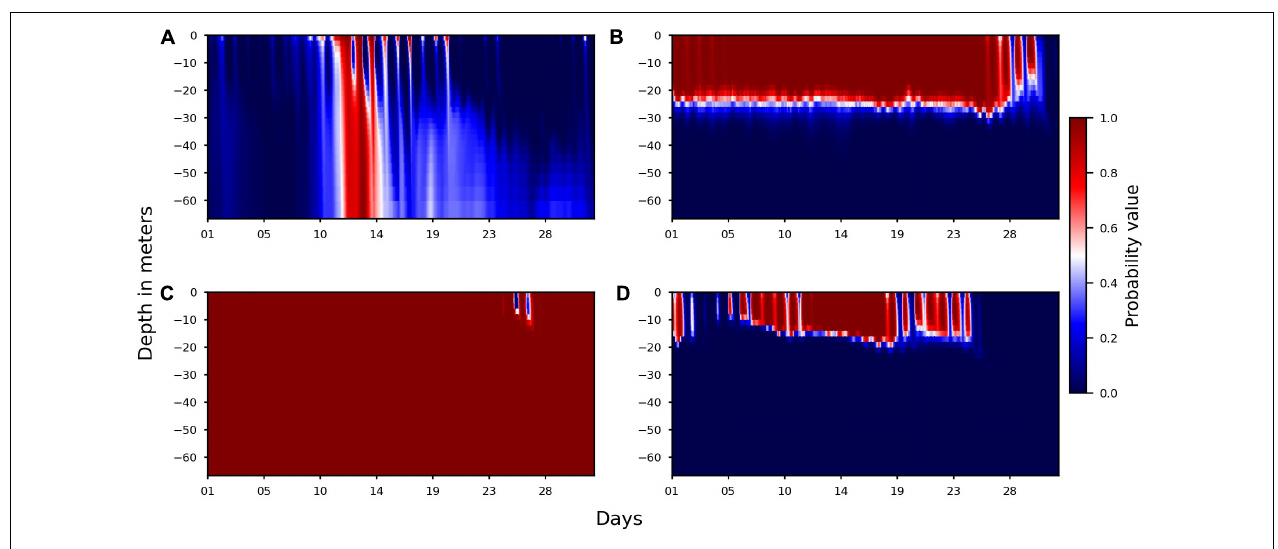
FIGURE 9 | Vertical plots of probability of (A) non-exceedance of 15 ◦ C at Ortholithi – March 2017, (B) exceedance of 26 ◦ C at Ortholithi – August 2017, (C) non-exceedance of 15 ◦ C at Ovrios – March 2017, and (D) exceedance of 26 ◦ C at Ovrios – August